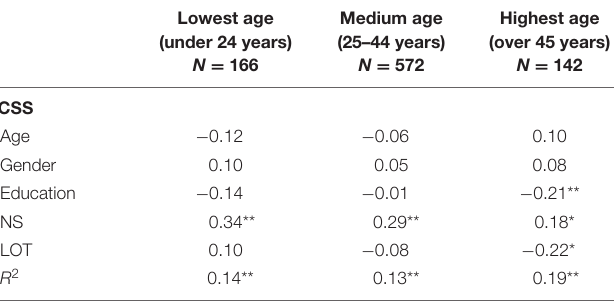
TABLE 3 | Hierarchical regression model for cyberchondria (CYB) at each age level.